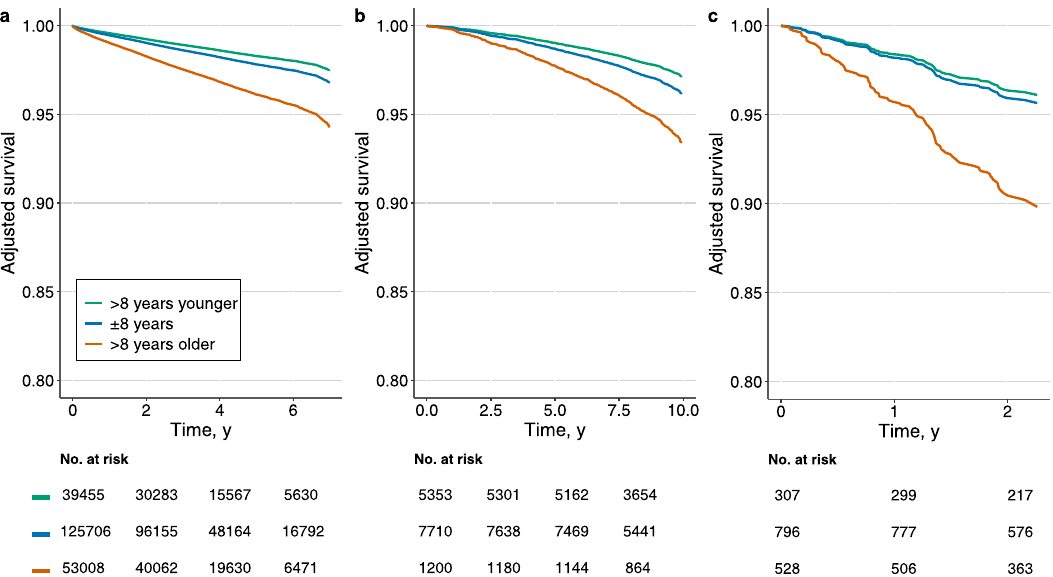
Fig. 2 Adjusted survival curves. The plots display the survival curves for the different cohorts. a CODE-15% cohort, b ELSA-Brasil cohort, c SaMi-Trop cohort. The curves are computed from the age and sex-adjusted Cox proportional model for all-cause mortality. Three groups of patients are taken into consideration: those with ECG-age more than 8 years greater than the chronological age (denoted by: “ >8 years older ” ); those with ECG-age within a range of 8 years from their chronological age (denoted by: “ ±8 years ” ); and, those with ECG-age more than 8 years smaller than the chronological age (denoted by: “ >8 years younger ” ). Table 3 ECG